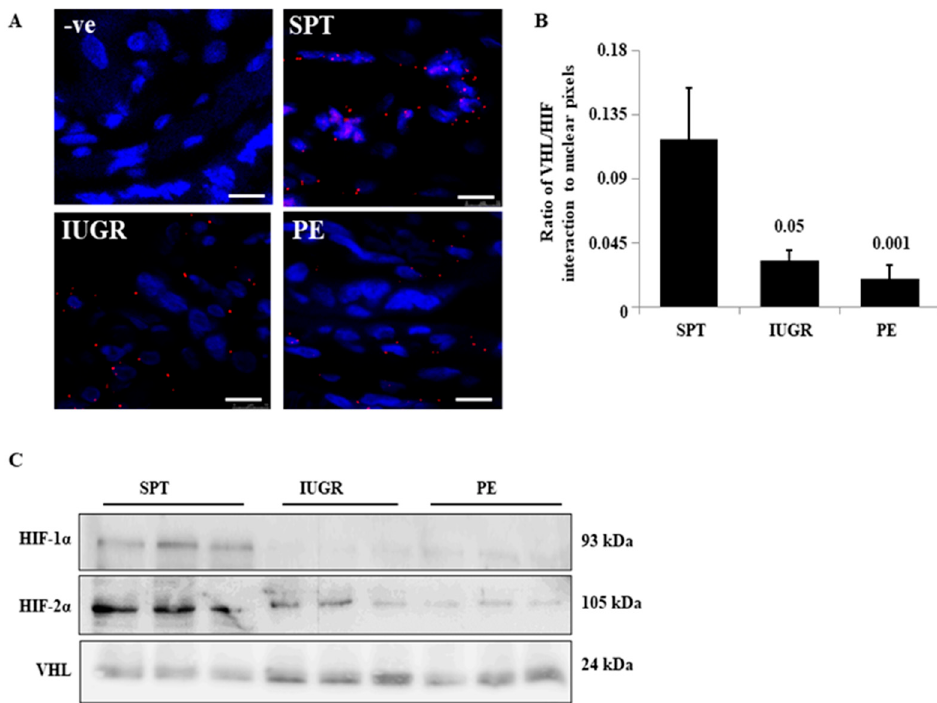
Figure 5. Interaction of HIF-1 α and VHL in the placentae of complicated pregnancies in situ. ( A ) The interaction of HIF-1 α and VHL was assessed in situ for normal ( n = 5), IUGR ( n = 4), and PE ( n = 4) pregnancies using the proximity ligation assay. The representative images show the interaction as red dots. ( B ) Staining was quantified by normalising signal from the PLA (pixel counts) with nuclear staining from the DAPI counterstain. p -values are compared to normal pregnancy. Scale bare represents 100 µ m (original magnification, x100) ( C ) Complex formation was assessed in lysates of normal ( n = 3), IUGR ( n = 3), and PE ( n = 3) by immunoprecipitation, pull-down was performed using anti-VHL and complexed HIF-1 α and 2 α were assessed by immunoblotting. Full gels for Co-IP can be found in SF6.